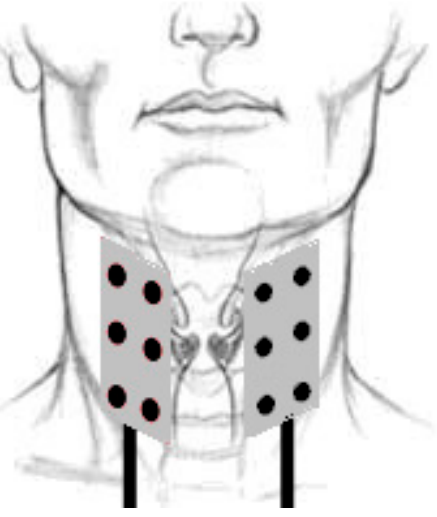
Figure 6. Application of MC ‐ EGG on humans.